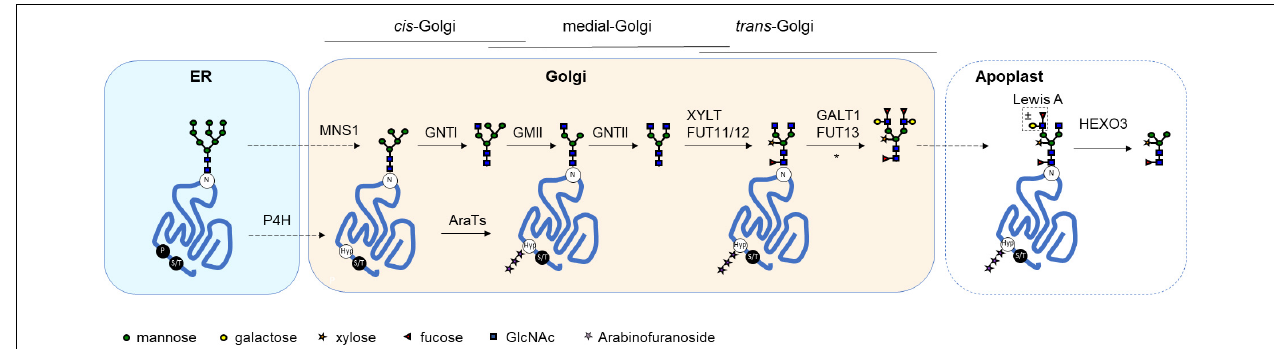
FIGURE 1 | Glycosylation pathways in plants. A schematic overview of successive glycan modifying steps in the plant secretory pathway. Glycoproteins receive an N- glycan in the endoplasmic reticulum (ER) on an asparagine residue (N) within the consensus sequence ( N- X-S/T), where X can be any amino acid except proline. After ER quality control, the correctly folded protein passes through the Golgi compartment. Within the Golgi immature high mannose-type N- glycans are modified in a tightly regulated process. First, Golgi α -mannosidase I (MNS1) trims down the N- glycan to a Man5 structure. In subsequent steps a diantennary N- glycan is synthesized, which in plants is substituted with core α 1,3-fucose and β 1,2-xylose. In some cases [as indicated by an asterisk (*)], this N- glycan is further extended with Lewis A motifs. Once secreted into the extracellular space (or apoplast) a terminal GlcNAc glycan structure can be trimmed down to a paucimannosidic glycan by the β -hexosaminidase HEXO3. Classical O- glycan synthesis in plants is initiated by the hydroxylation of proline residues by prolyl-4-hydroxylases (P4H) in the ER and/or Golgi. These hydroxyproline residues (Hyp) can then be substituted with extensin-like O- glycans (substitution with arabinofuranoside by AraTs) or more complex arabinogalactan O- glycans, recently reviewed in Petersen et al. (2021). In contrast to animals, serine (S) and threonine (T) residues are not substituted with O- glycans in plants. GnTI, N -acetyl-glucosaminyltransferase I; GMII, Golgi- α -mannosidase II; GnTII, N -acetyl-glucosaminyltransferase II; XYLT, β 1,2-xylosyltransferase; FUT11/12, Core α 1,3-fucosyltransferase; GALT1, β 1,3-galactosyltransferase; FUT13, α